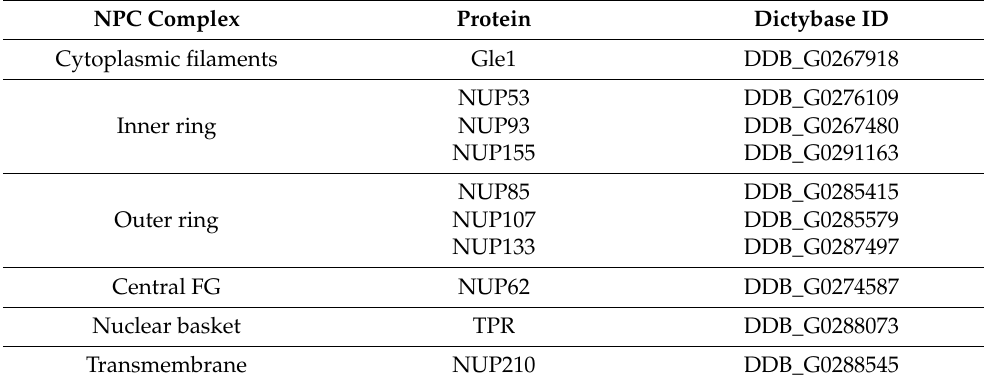
Table 1. Selected NUPs, their Dictybase Gene ID and the corresponding NPC